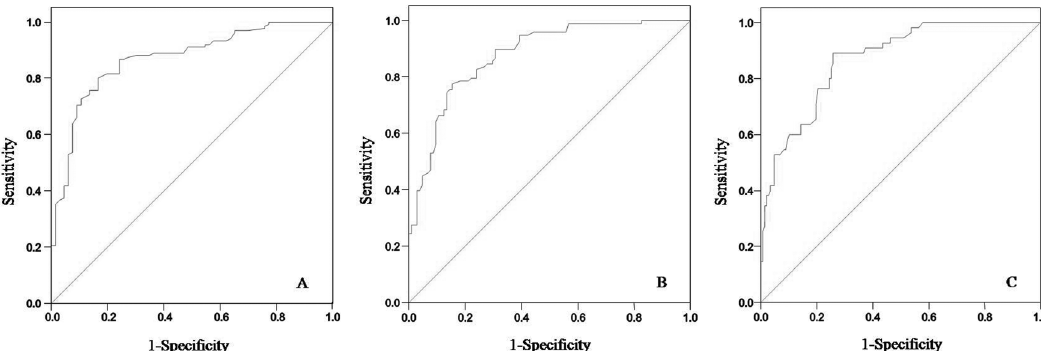
Figure 2 - Receiver operating characteristic (ROC) curves of the accuracy of the gross tumor volume (GTV) in differentiating N categories in patients with resectable gastric adenocarcinoma in the T1-T4a categories. The ROC curve shows that the GTV could help to